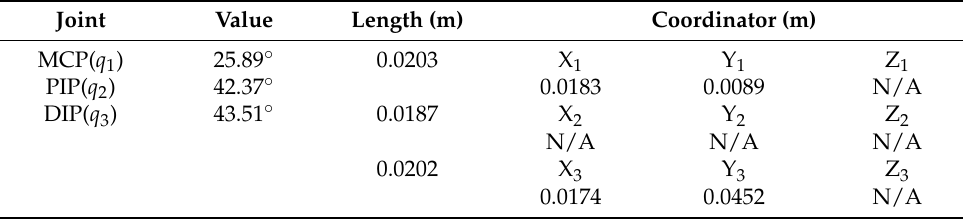
Table 4. Values from inverse kinematics